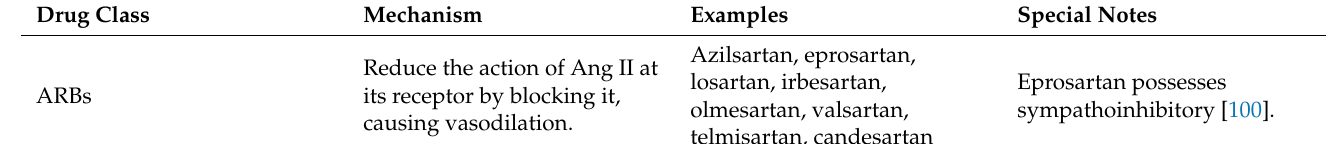
Table 1. Cont. Table 1 provides a list of current antihypertensive drugs that can be used in combination to manage